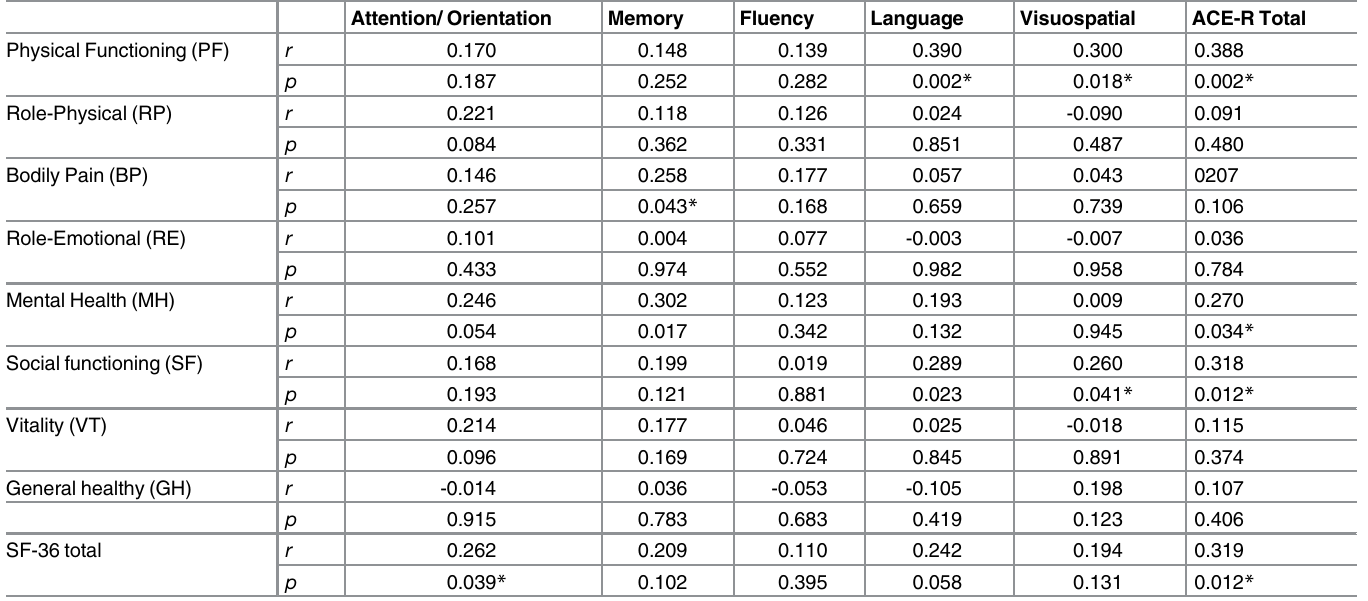
Table 3. Relationship between the ACE-R and SF36 scores in BSP patients (n = 68).